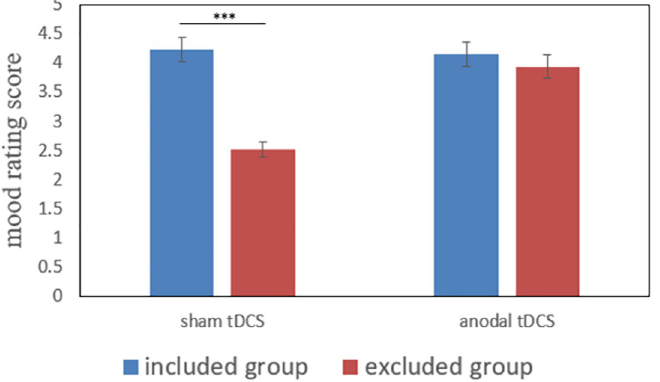
Fig 2. Mood rating scores for excluded and included participants receiving anodal or sham stimulation. Error bars represent SEMs. *** p < 0.001.